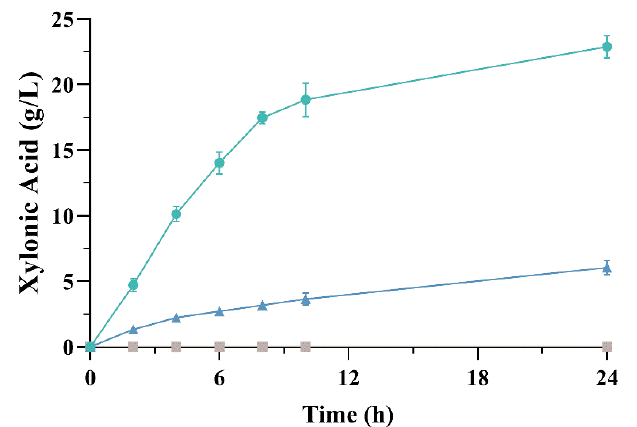
Figure 2. Comparative production of xylonic acid between ZM4 BX (green circles), ZM4 BXL